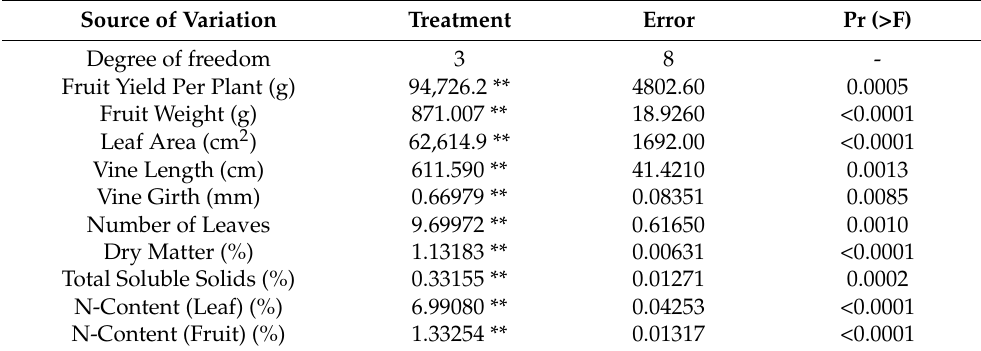
Table 3. Mean Squares from One-way ANOVA for different productivity-enhancing traits of Cucum- ber under Soilless